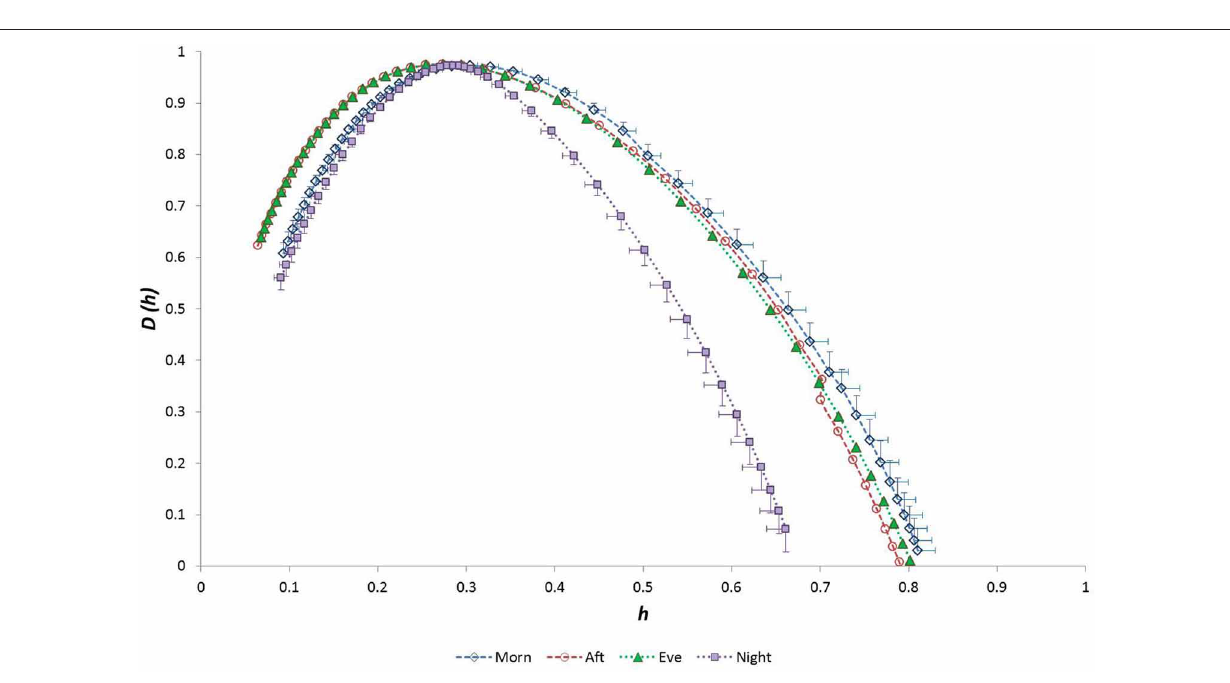
FIGURE 7 | Singularity multifractal spectra by “time of day” for the whole